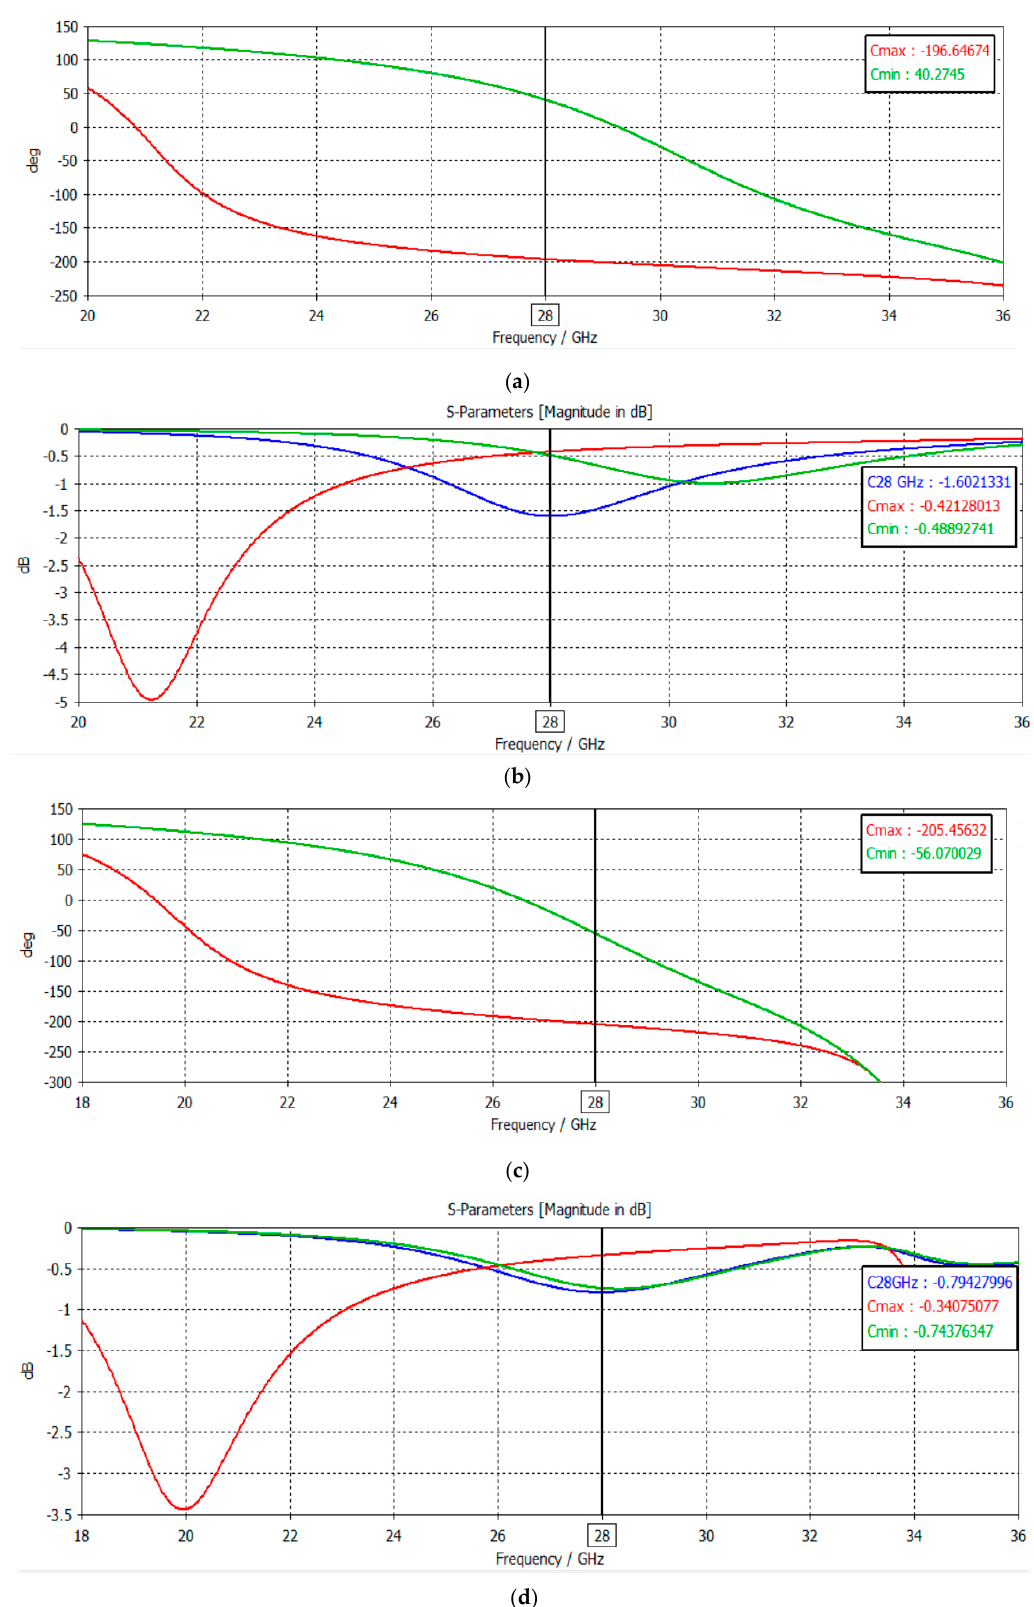
Figure 4. Unit cell reflection simulation results. ( a ) Type A—Phase. ( b ) Type A—Magnitude. ( c ) Type B—Phase. ( d ) Type B—Magnitude.